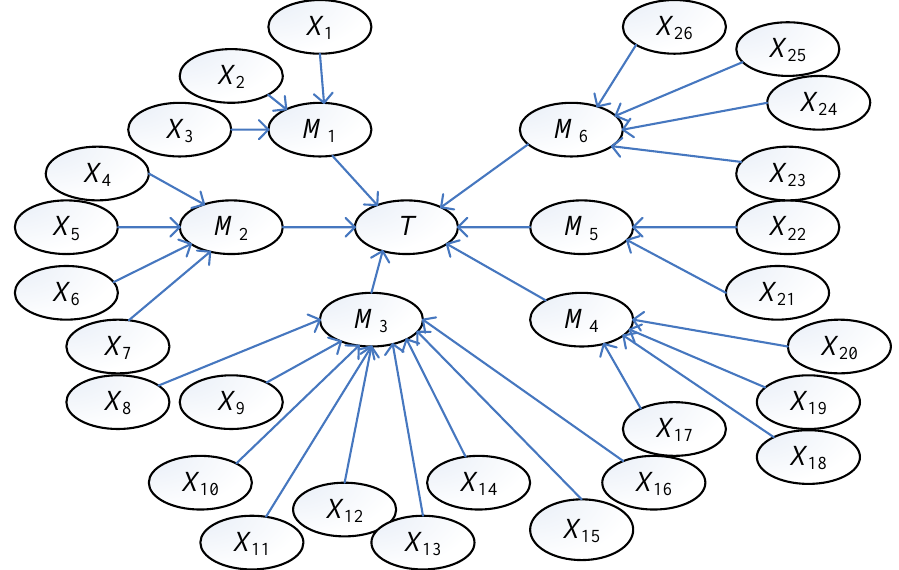
Figure 3. Bayesian network model for pipeline failure factor.